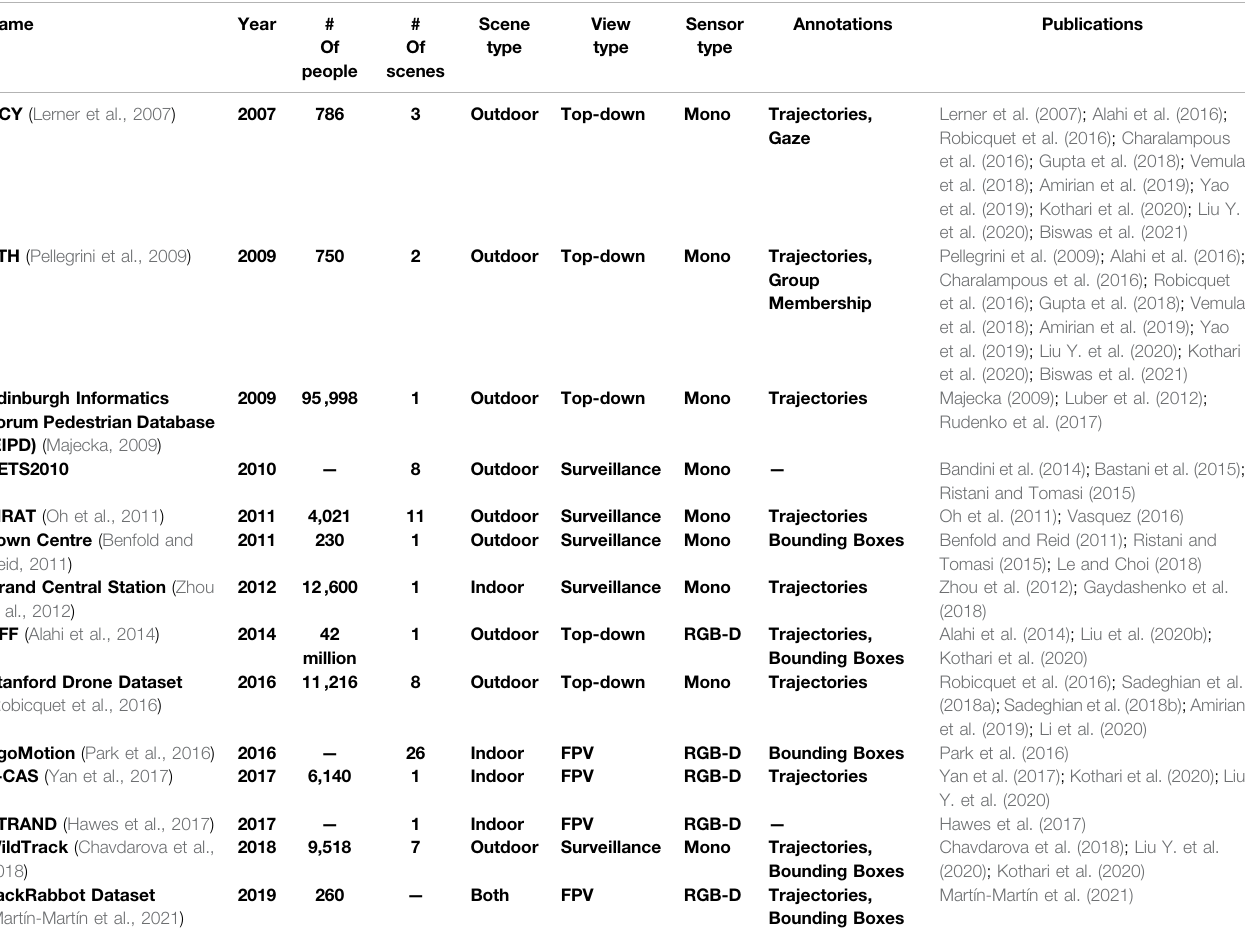
TABLE 3 | Datasets used in socially-aware